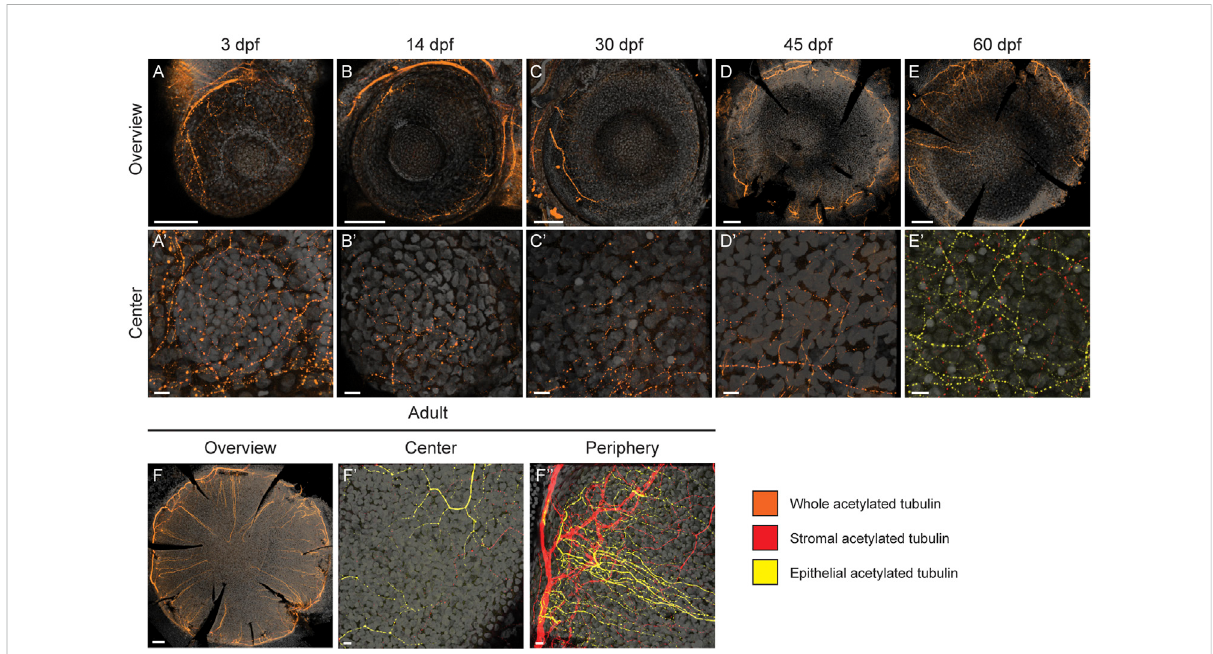
Corneal innervation in different age groups. Acetylated tubulin whole mount staining on maximum intensity projection images of whole eyes (A – F) and in central regions (A 9 – F 9 ) . Additionally, the peripheral/limbal region is shown for adult stage (F ’’ ) . Orange color indicates the signal on the entirecorneal tissue,yellowreferstotheepithelialcompartment,andredtothestromalcompartment.During the fi rst1.5 months (A 9 – D 9 ) thesignal remains scarse on central cornea; the thickest neuronal branches can be observed in the peripheral regions (A – D) . At 60 dpf, the innervation is getting more dense, and distinct stromal (red) and epithelial (yellow) processes can be identi fi ed (E,E 9 ) . In the adult cornea, thick peripheral nerve fi bersbranchandentertheepithelialcompartment,forminganeven,centrally-orientedpattern (F – F) .Theepithelial versus stromal fi